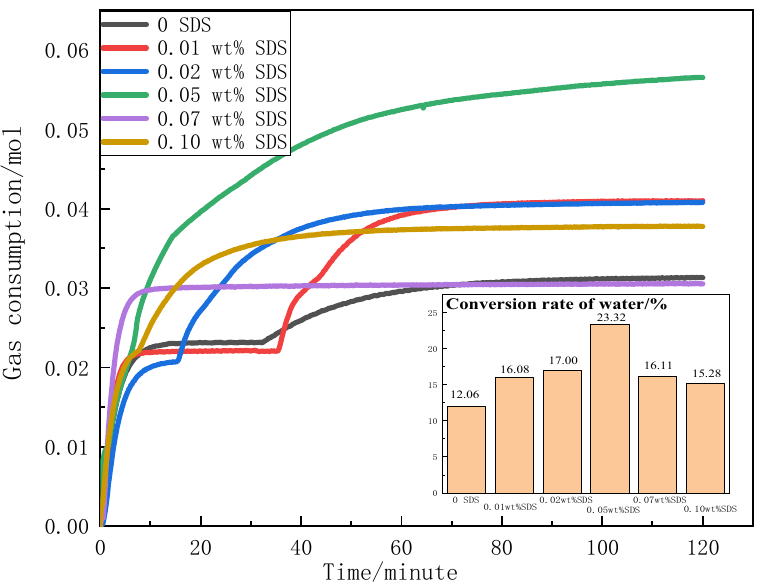
Figure 3. Gas consumption of hydrate formation and comparison diagram of hydrate conversion in 3.5 wt.% NaCl and SDS solution.